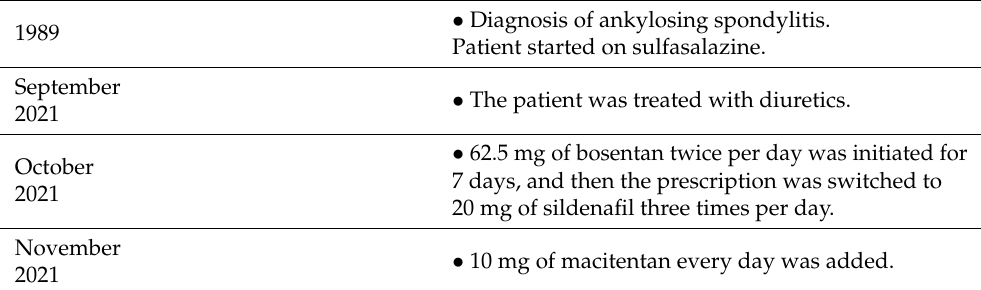
Table 3. Timeline of the patient’s